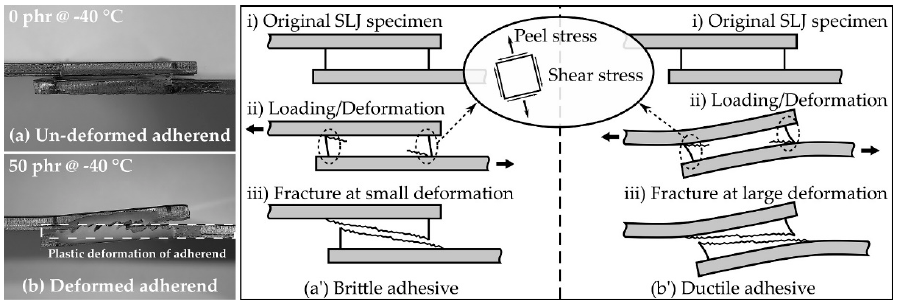
Figure 10. Side view of the fractured SLJ specimens overlapped manually for photographs for the ( a ) un-deformed adherend (0 phr @ − 40 °C) and ( b ) deformed adherend (50 phr @ − 40 °C). Schematic illustration of SLJ deformation on the ( a’ ) brittle adhesive and ( b’ ) ductile adhesive.